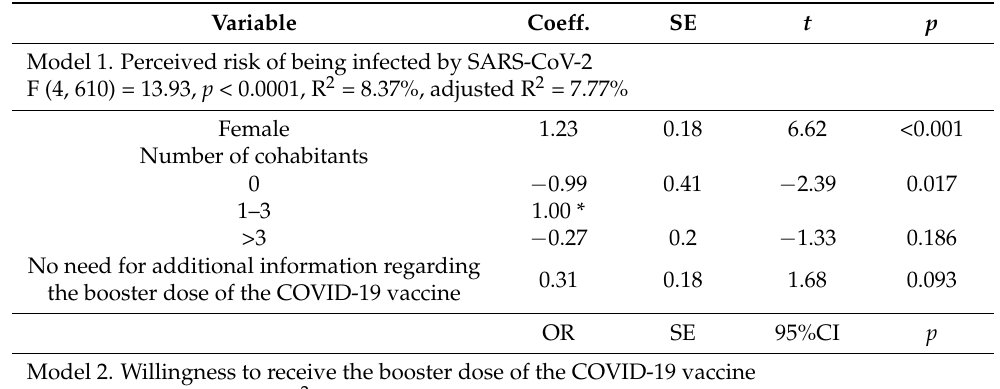
Table 2. Multivariate linear and logistic regression analysis results examining the outcomes of interest according to several explanatory variables. Variable Coeff. SE t p Model 1. Perceived risk of being infected by SARS-CoV-2 F (4, 610) = 13.93, p < 0.0001, R 2 = 8.37%, adjusted R 2 = 7.77%